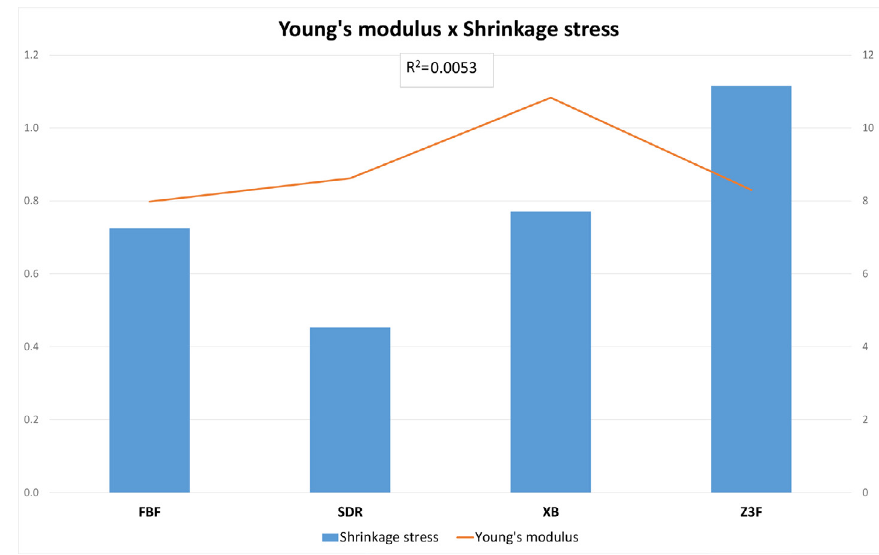
Figure 5- Young’s modulus (GPa) x Shrinkage Stress (MPa) for low-viscosity